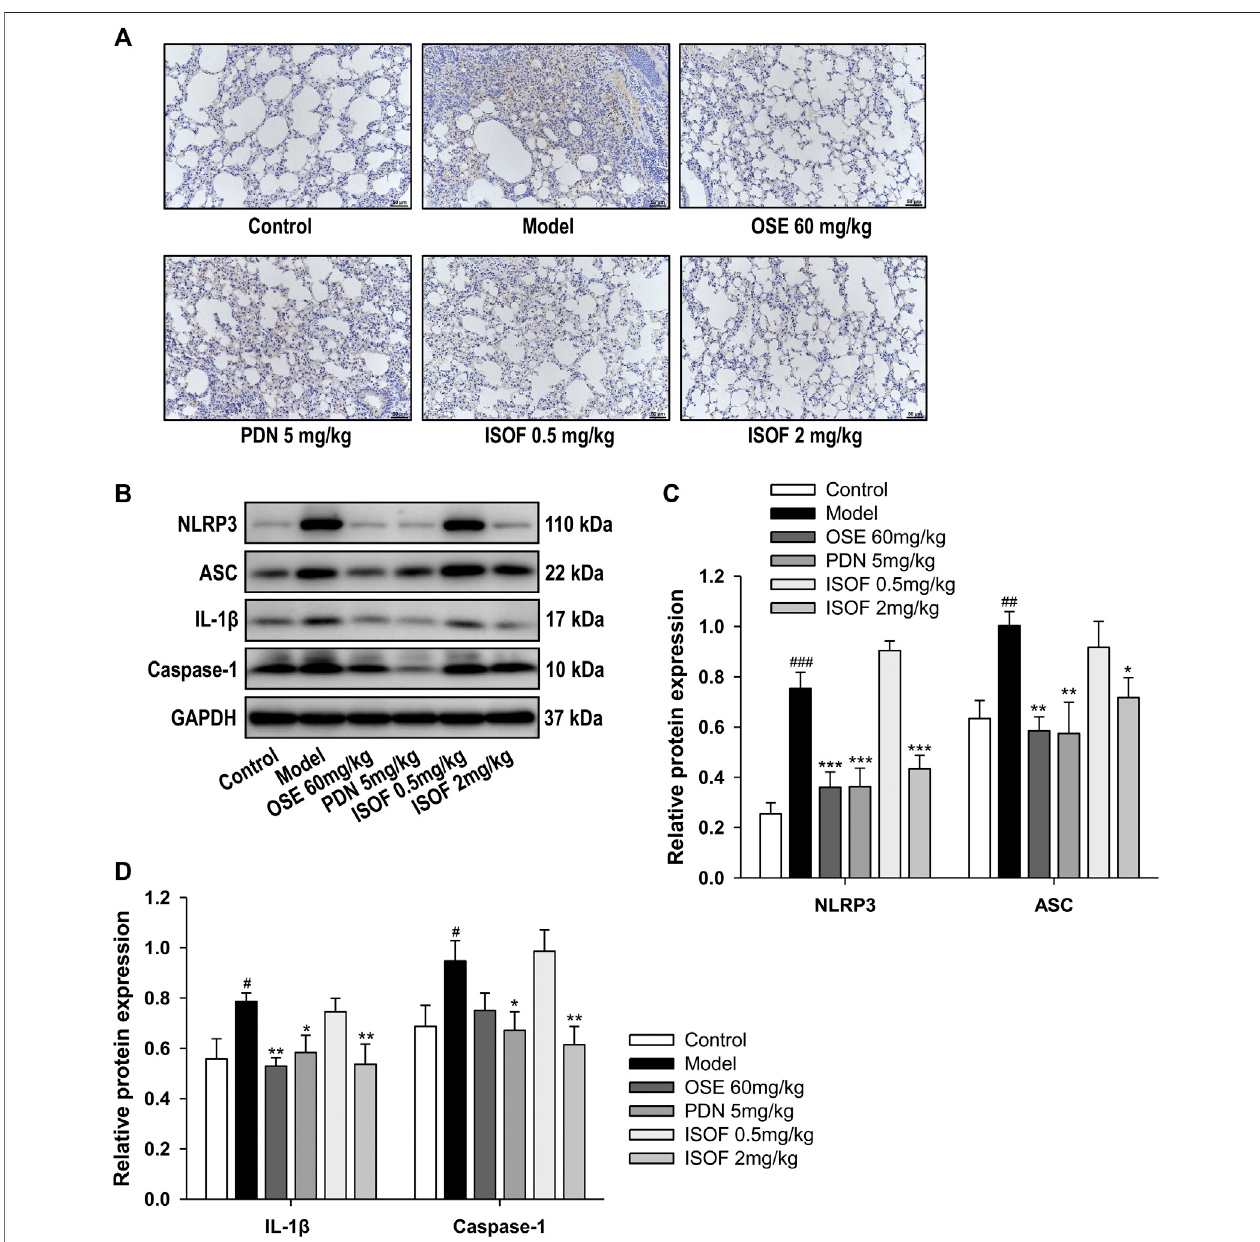
FIGURE 8 | ISOF attenuated NLRP3 in fl ammasome activation in the lung tissues of AECOPD model mice. (A) Immunohistochemistry analysis of NLRP3 expression in the lung tissues of each group (original magni fi cation: 200 × ). Scale bar (cid:1) 50 μ m. (B) The protein levels of NLRP3, ASC, IL-1 β , and caspase-1 in the lung tissuesofeachgroupwereassessedbywesternblot. (C) TherelativedensityofNLRP3orASCtoGAPDHineachgroup. (D) TherelativedensityofIL-1 β orcaspase-1to GAPDHin each group. Dataare expressed asmeans ± SEM( n (cid:1) 4in each group). # p < 0.05, ## p < 0.01, and ### p < 0.001vs. controlgroup; * p < 0.05, ** p < 0.01, and *** p < 0.001 vs. model